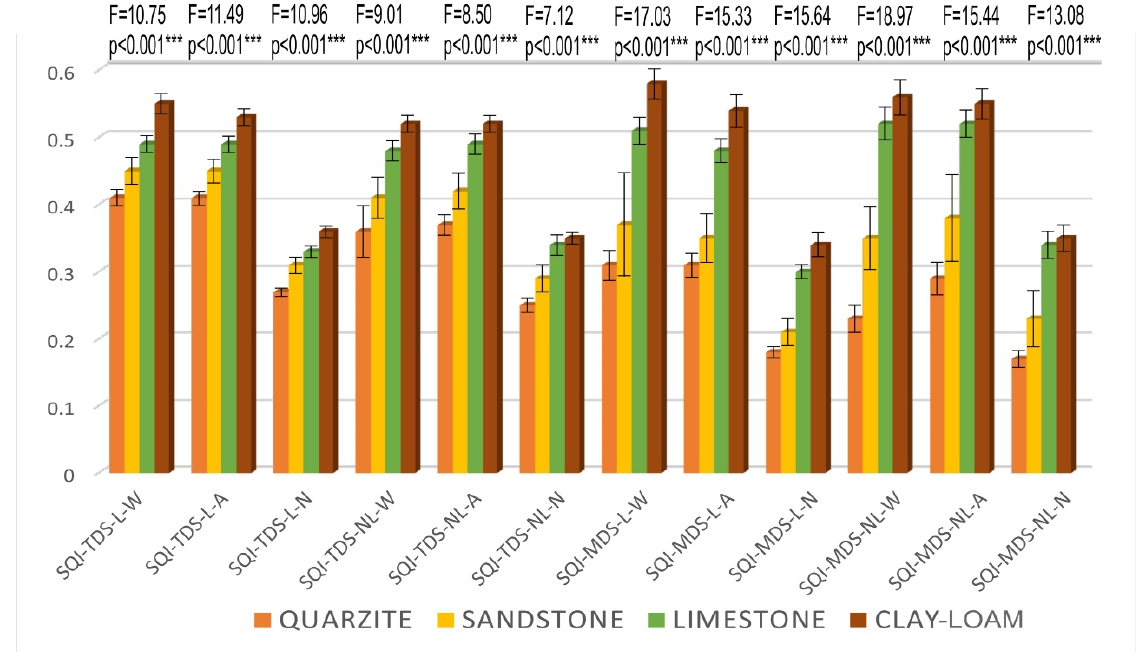
Figure 8. Comparison of the soil quality indices developed in this study in different land uses. The bars represent the standard deviation. The F and p values were the results of the ANOVA test.